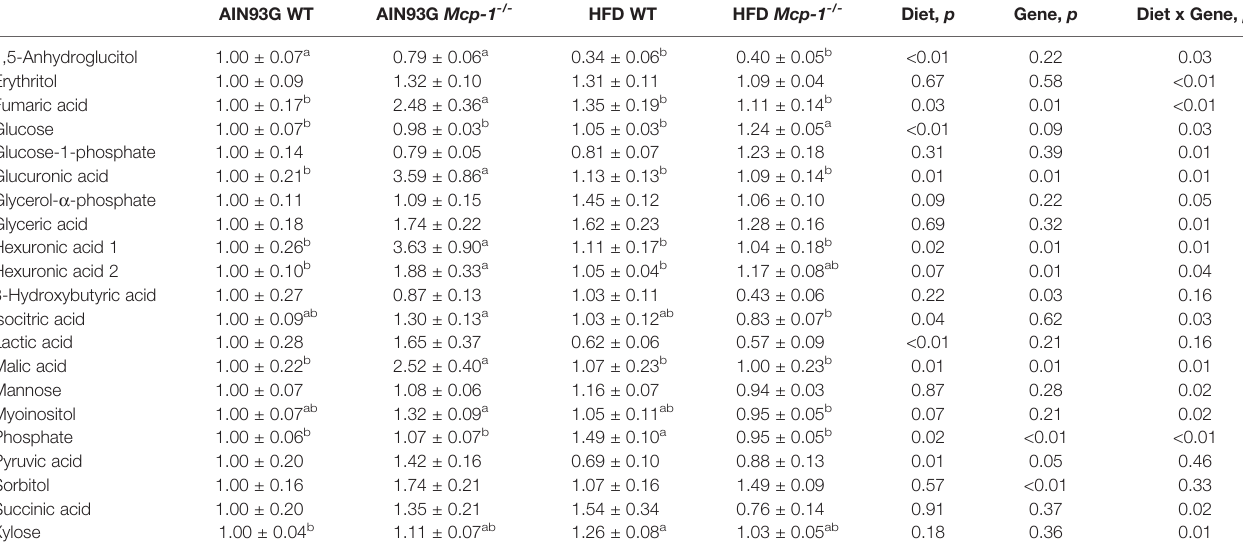
Values of treatment groups are standardized to that of the AIN93G WT group. Values (means ± SEM) in the same row with different letters are signi fi cant at p ≤ 0.05 (false discovery rate- adjusted p values) (n = 10 per